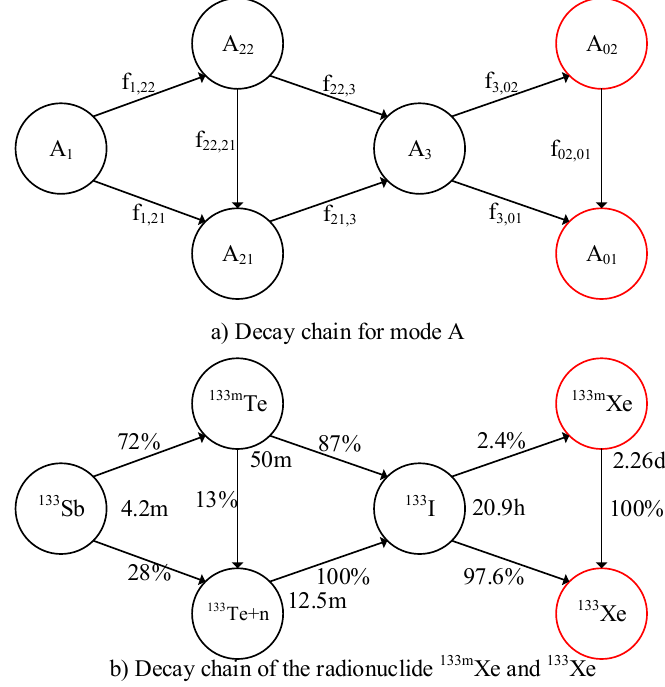
Figure 2. Calculation flow of the IPRFGN model. Fission gas nuclides normally have two general modes in terms of the number of decay chains: General Modes A and B. In this study, both modes were evaluated. The former is depicted in Figure 3a [45,54], in which the reaction branching ratios were obtained from KORIGEN nuclear data libraries, as these were the most recent data available from the Evaluated Nuclear Structure Data File (ENSDF) of the International Atomic Energy Agency (IAEA) [45,55,56].